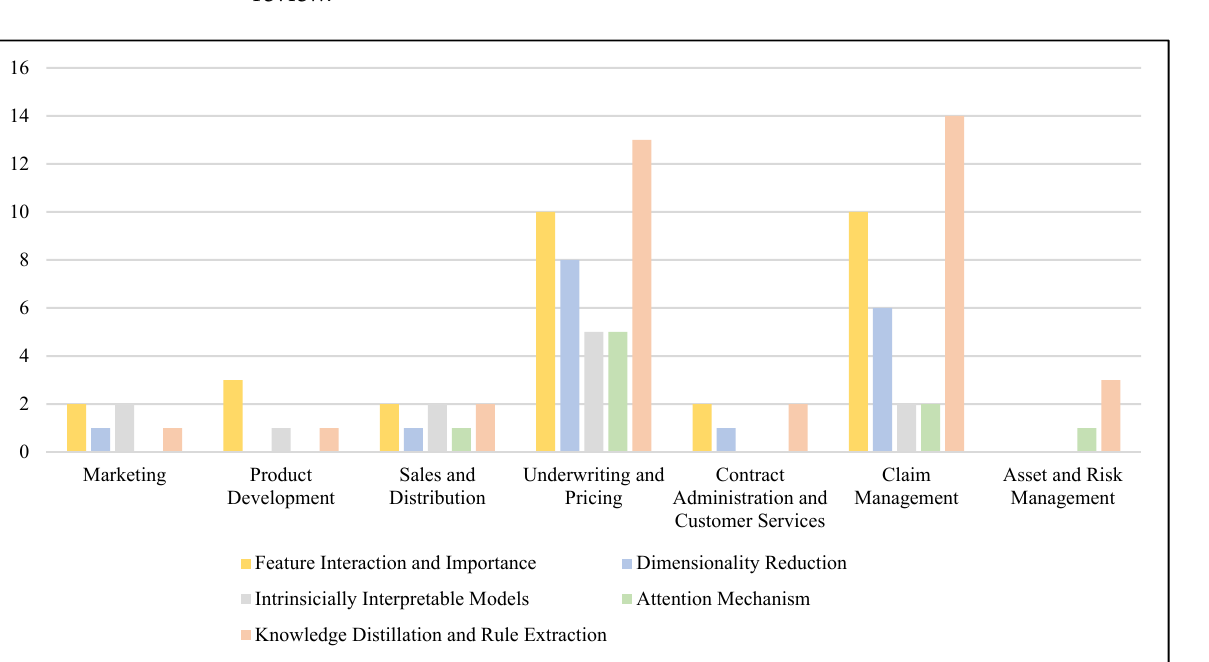
Figure 4. IVC Stage and Corresponding XAI Method Employed present the seven IVC stages assessed in the systematically chosen articles and the XAI method used in their methodology. Support Activities is not included in this paper as no articles returned in the systematic literature search presented prediction tasks in line with insurance companies’ Support Activities.